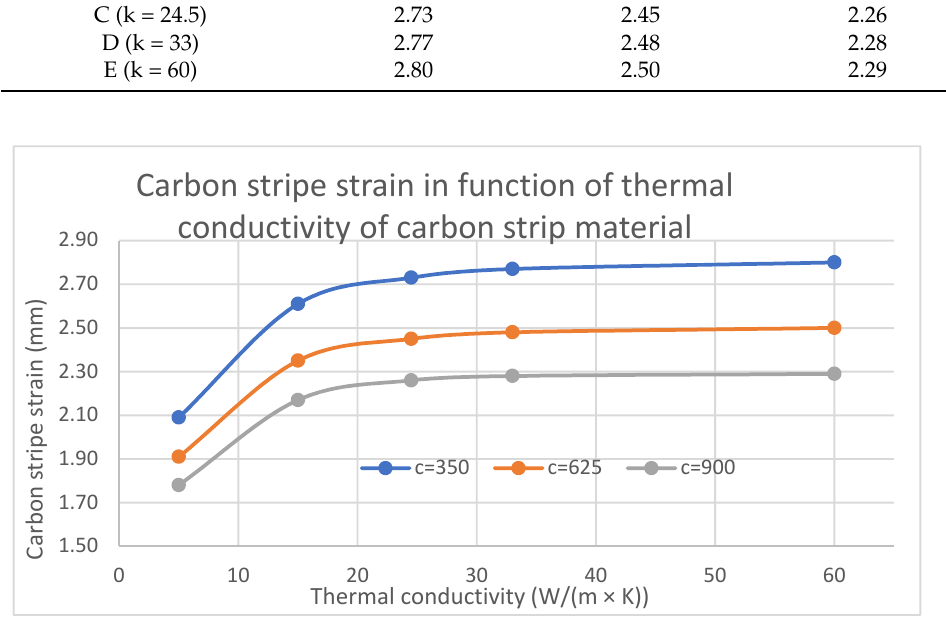
Figure 18. Contact wire temperature as a function of thermal conductivity of carbon strip material.